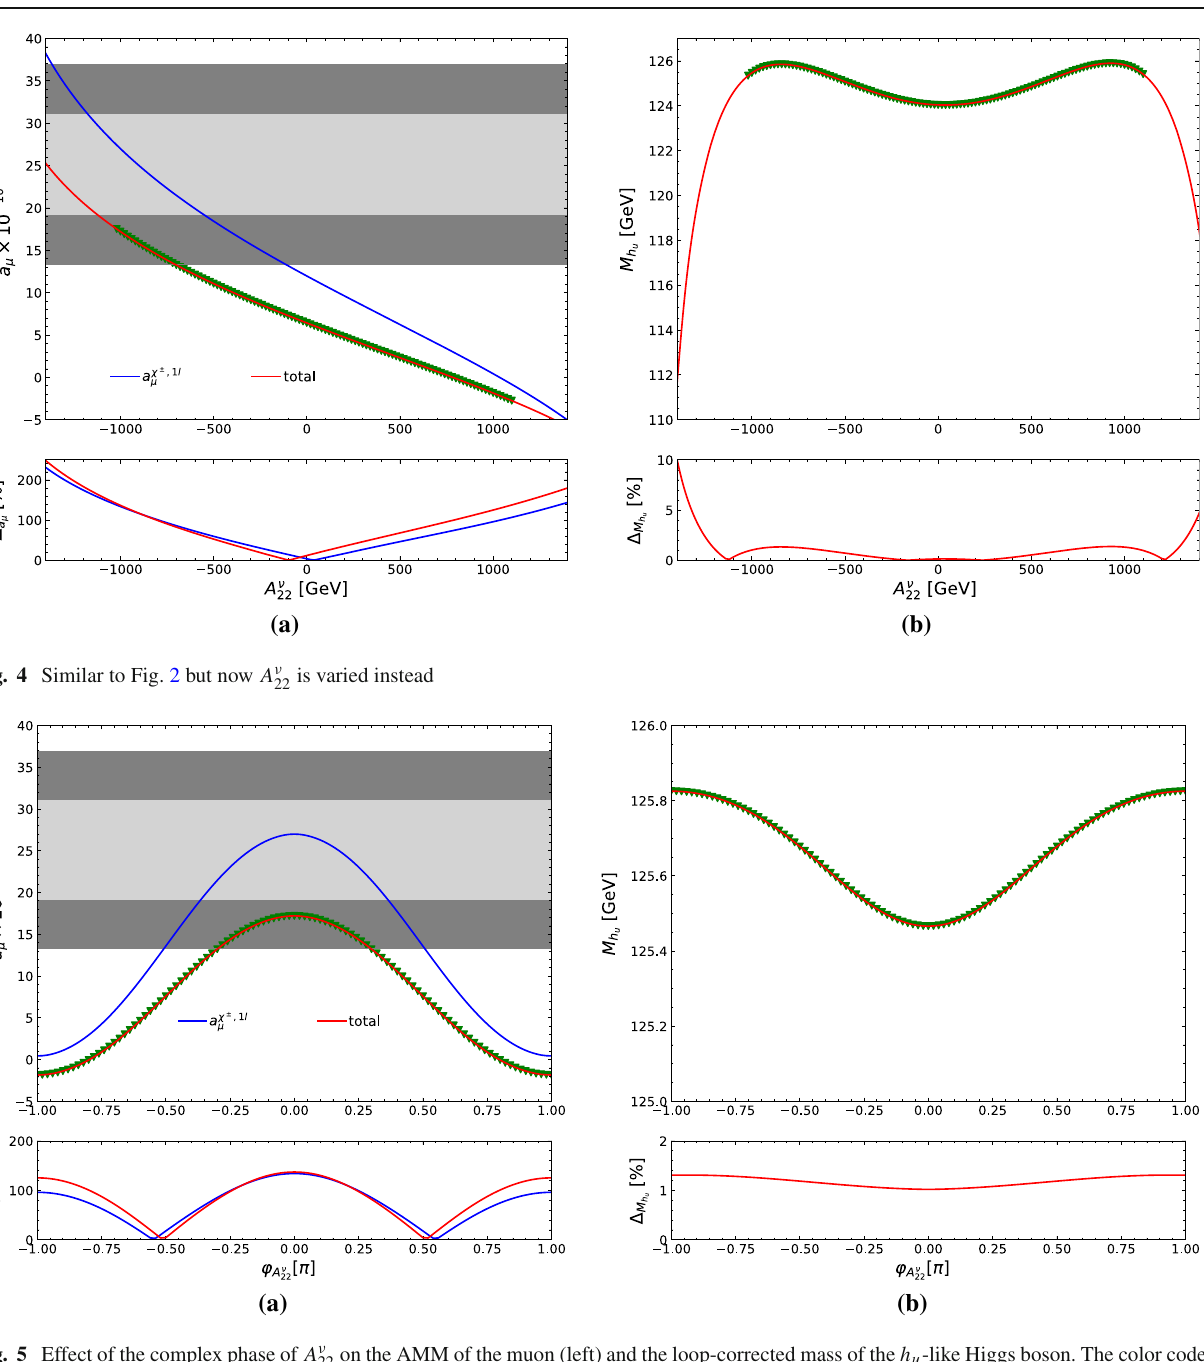
Fig. 5 Effect of the complex phase of A ν on the AMM of the muon (left) and the loop-corrected mass of the h u -like Higgs boson. The color code 22 is the same as Fig. 2